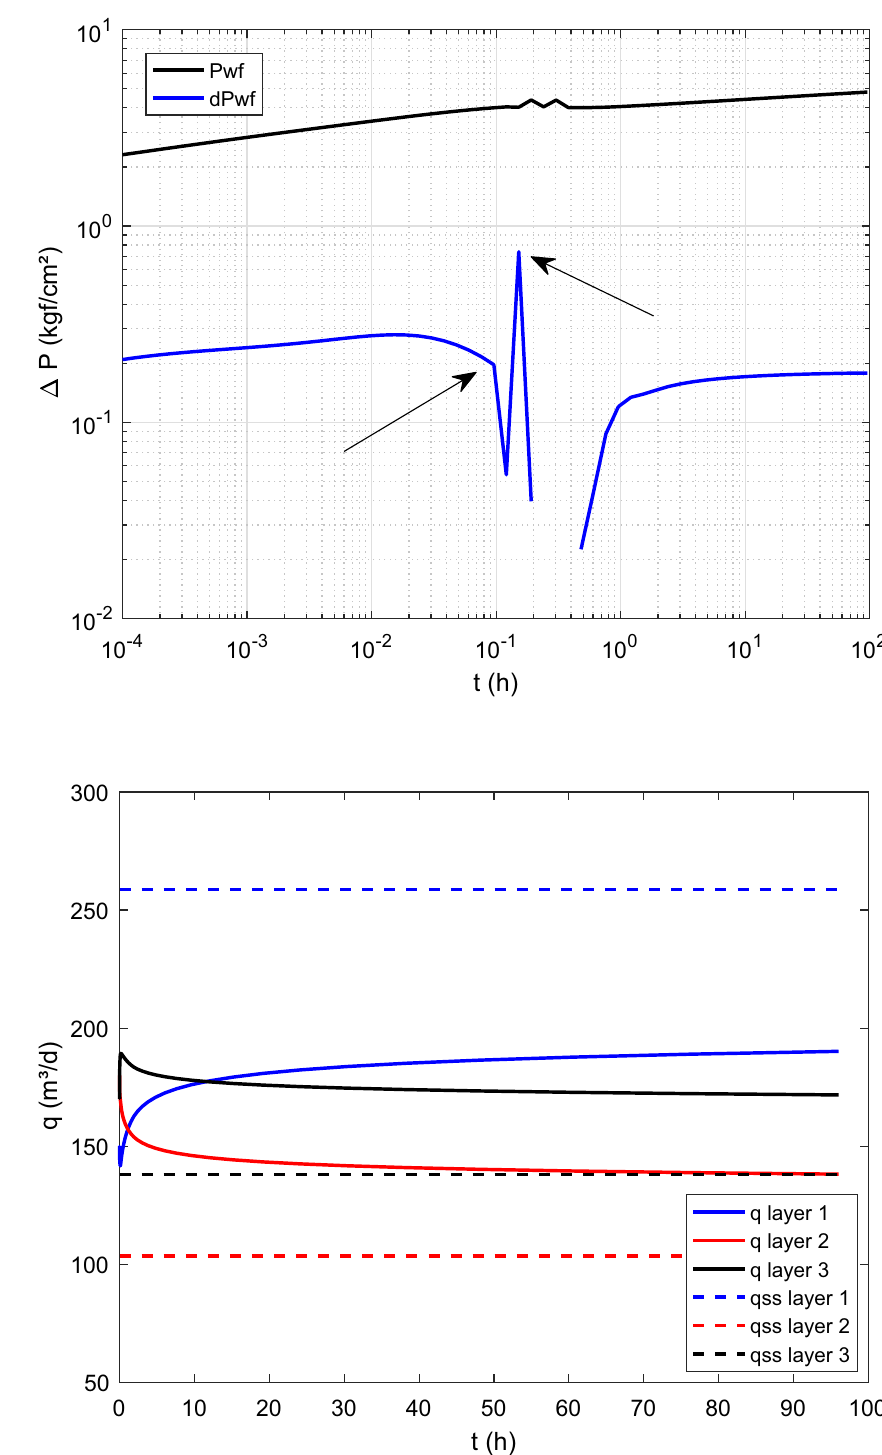
Fig. 5 Pressure and derivative data for case K